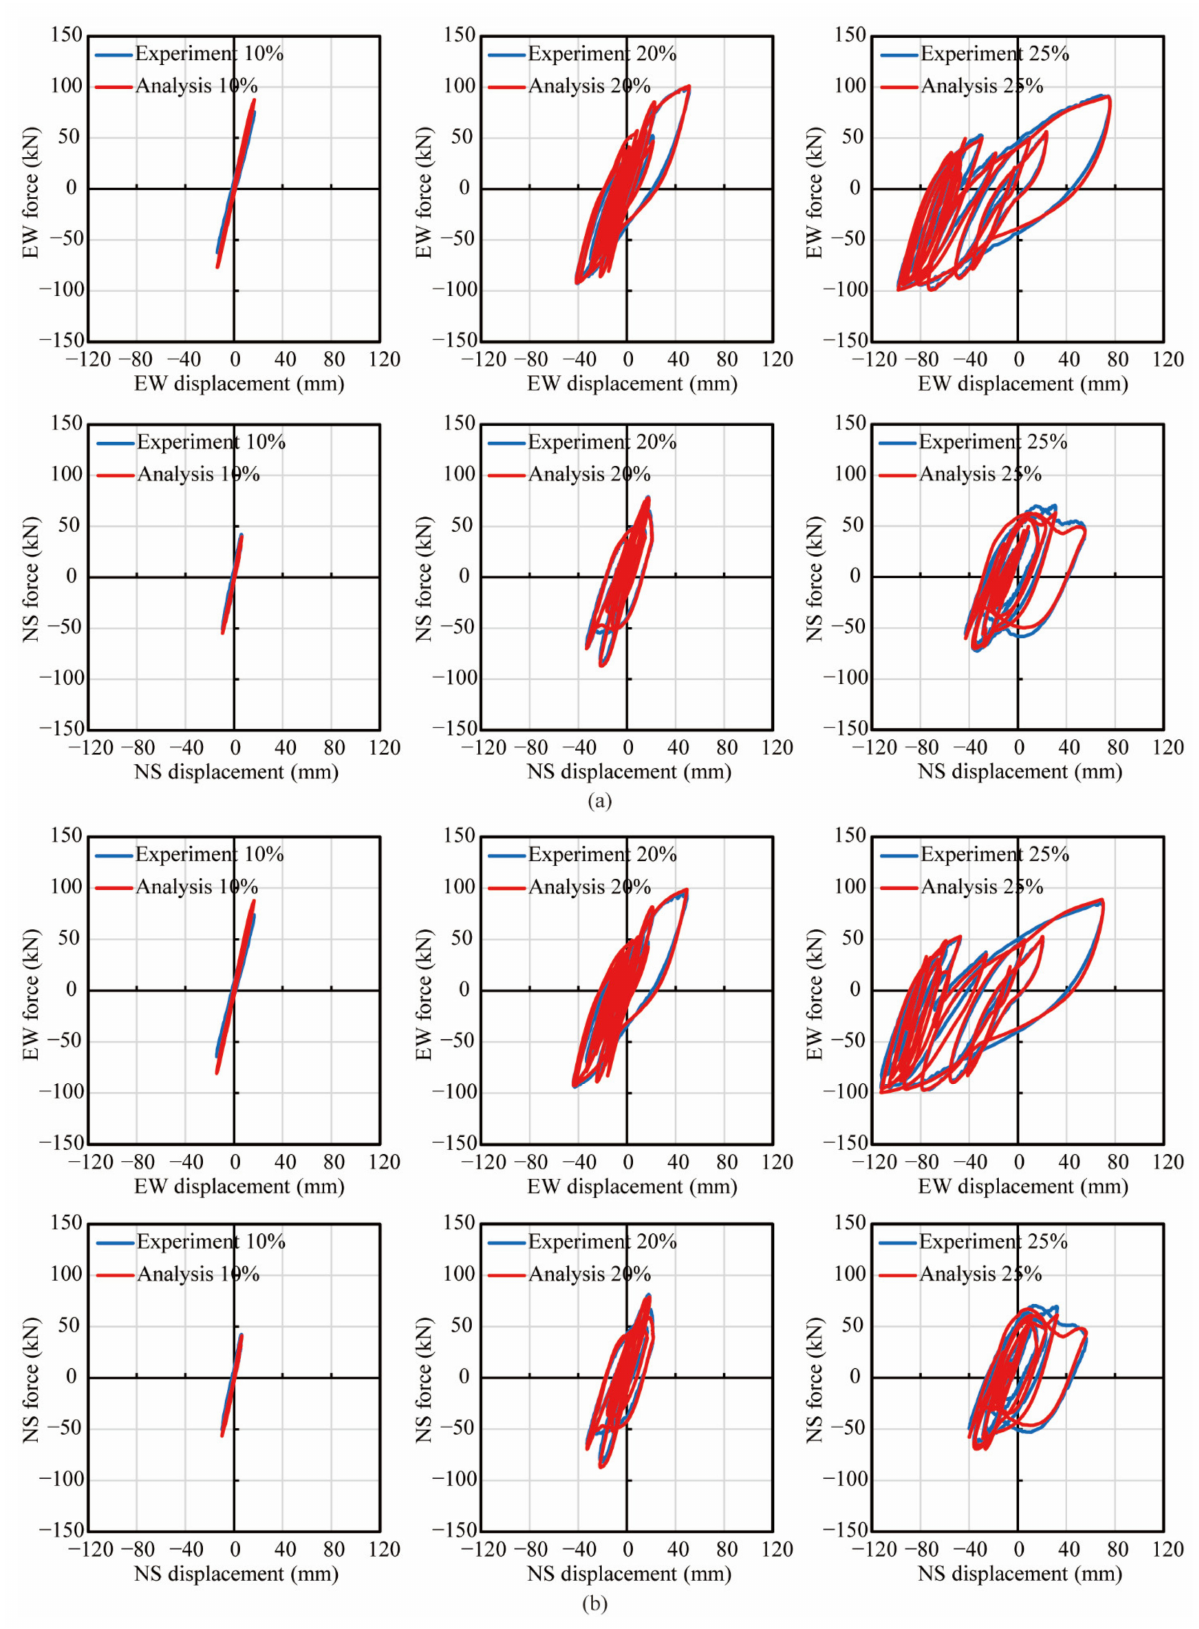
Figure 9. Analytical correlation of lateral forces vs. displacement with experimental results. ( a ) PFRC-1, ( b )